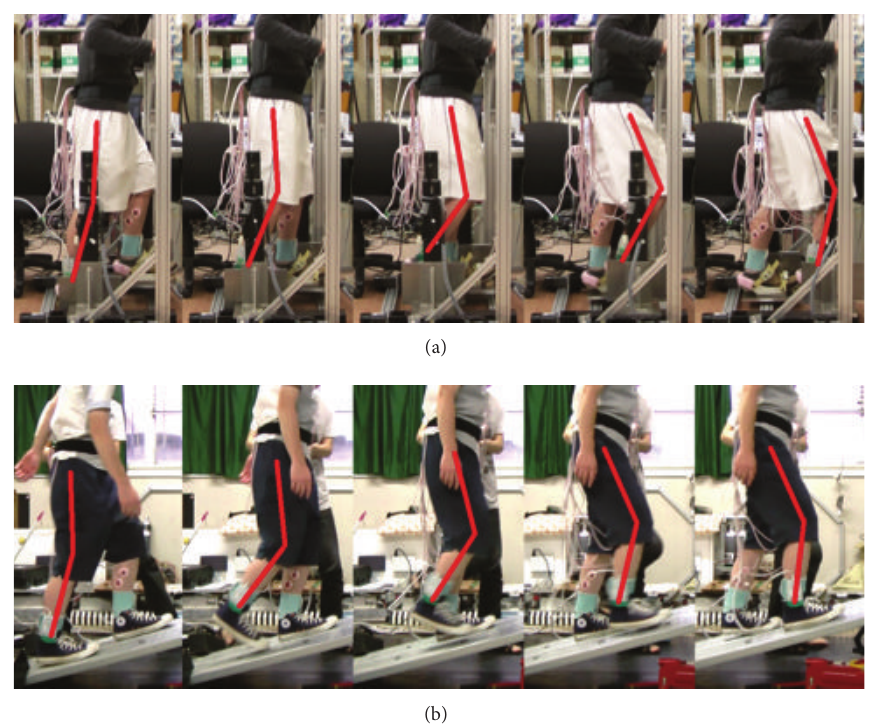
Figure 11: Typical motion during slope climbing ((a) on the GMmini and (b) on a real slope).